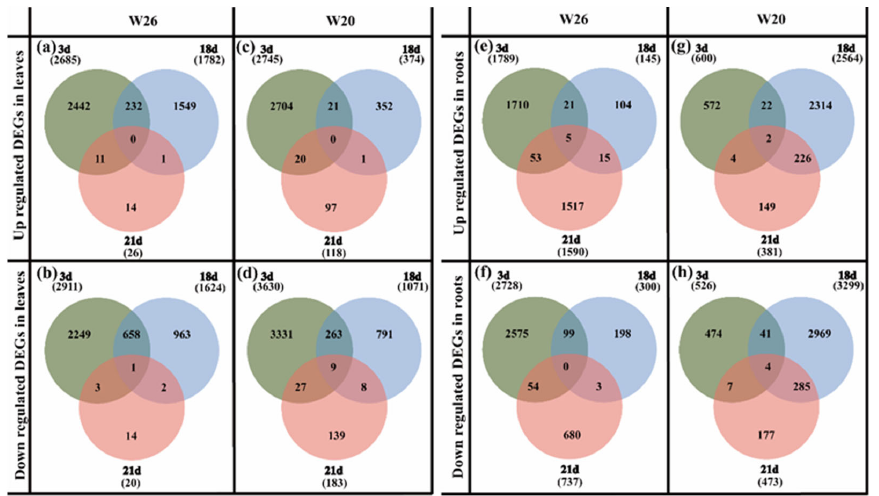
Figure 4. Venn diagram of DEGs W26 and W20 at different time points. ( a , b ) show the number of up ‐ regulated differentially expressed genes (DEGs) and down ‐ regulated DEGs in W26 leaves, respectively. ( c , d ) show the number of up ‐ regulated DEGs and down ‐ regulated DEGs in W20 leaves, respectively. ( e , f ) show the number of up ‐ regulated DEGs and down ‐ regulated DEGs in W26 roots, respectively. ( g , h ) show the number of up ‐ regulated DEGs and down ‐ regulated DEGs in W20 roots, respectively.